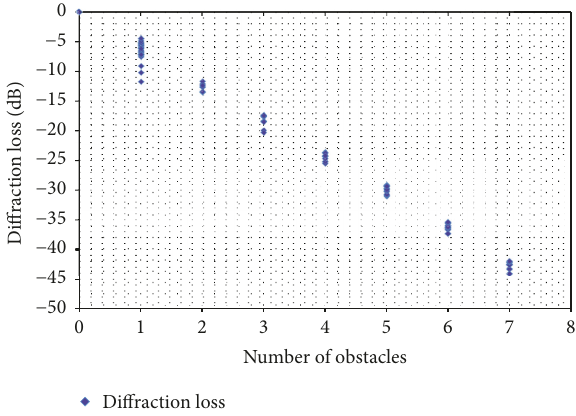
algorithm and other propagation mechanisms